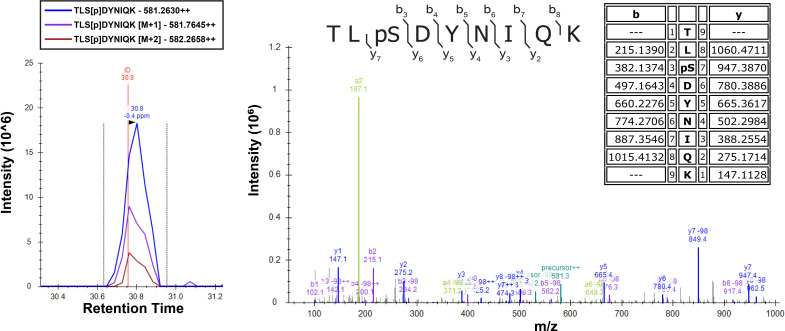
Identification and characterization of human MARK2 phosphorylation site on ubiquitin.In vitro phosphorylation experiment was performed using recombinant GST-MARK2 and 6×His-tetra-Ub as described in the Materials and methods. Theoretical masses of b/y ions are tabulated and MS-observed masses are shown in the spectra.